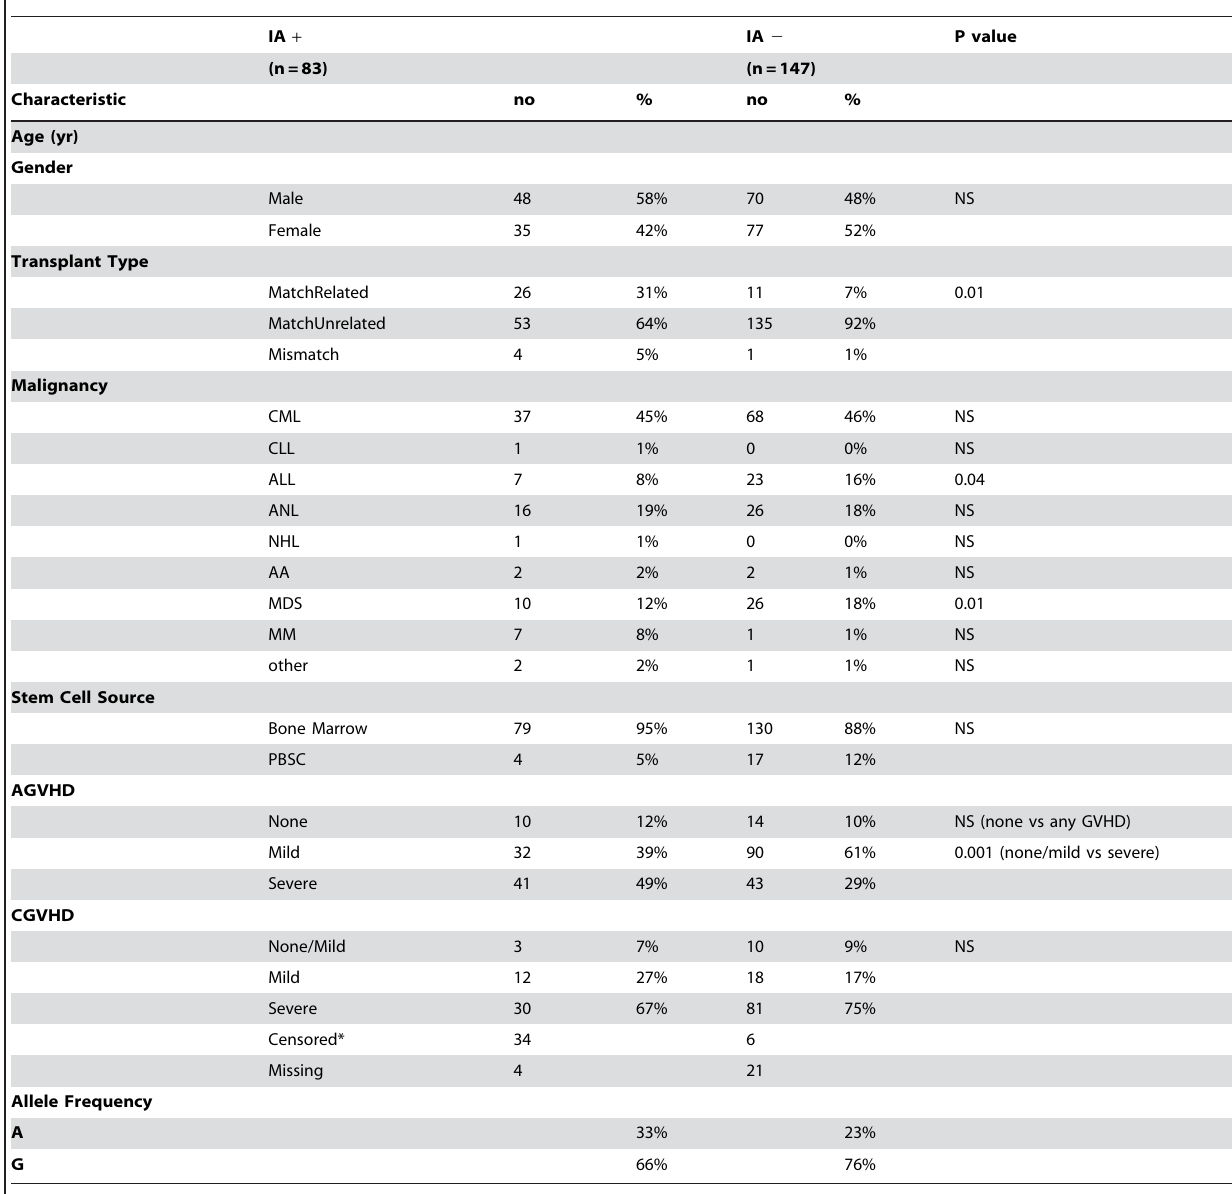
Table 1. Demographics of HSCT